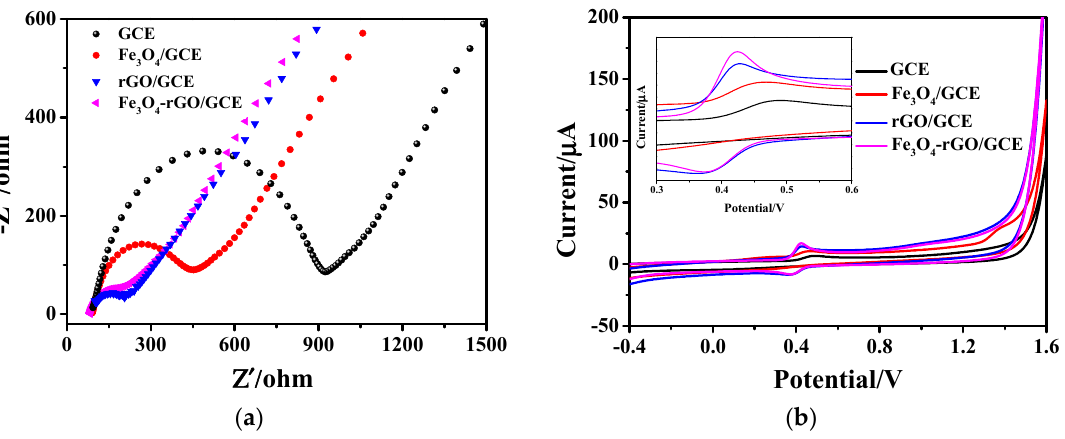
Figure 3. ( a ) EIS Nyquist plots of bare GCE, Fe 3 O 4 /GCE, rGO/GCE and Fe 3 O 4 -rGO/GCE in 0.1 M KCl solution and 5 mM [Fe(CN) 6 ] 3 − /4 − and ( b ) CV curves of 1 × 10 − 4 M AC for different electrodes at a scan rate of 100 mV·s − 1 in 0.2 M PBS buffer solution (pH = 5.0); inset: enlarged view of CV curves. Figure 4 shows the CV curves of 1 × 10 − 4 mol/L AC in PBS (pH = 5.6), Britton-Robinson (B-R, pH = 5.0), citric acid (CA)-sodium citrate (pH = 5.0) and HAc-NaAc (pH = 5.5) buffer solutions, respectively, with the hollow Fe 3 O 4 /rGO nanocomposite as a modified electrode. As can be seen from the figure, the peak shape of the oxidation peak of AC in PBS buffer is relatively narrower, and the peak current value is relatively higher, so PBS was chosen/selected as the buffer.